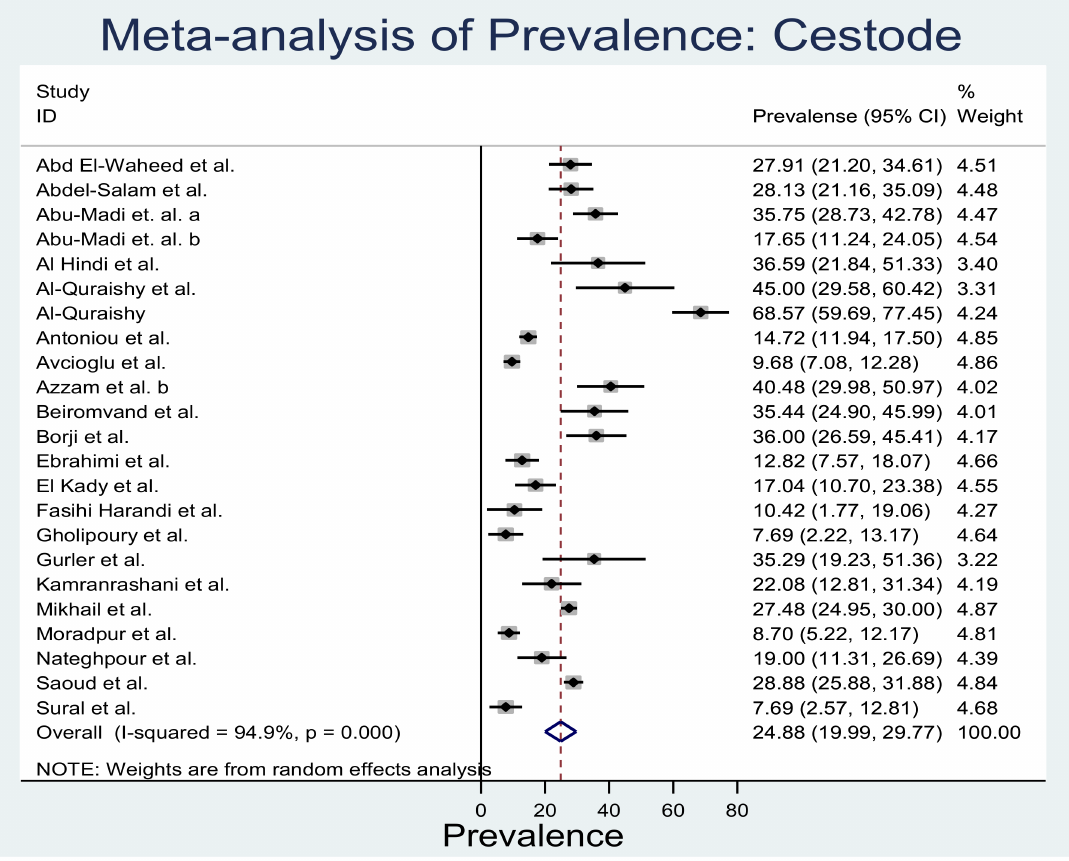
Figure 3. Forest plot of the prevalence estimates of cestode in rodents among the Middle East countries (the center dot representing point estimates whereas Gray Square representing the weight of each study to the